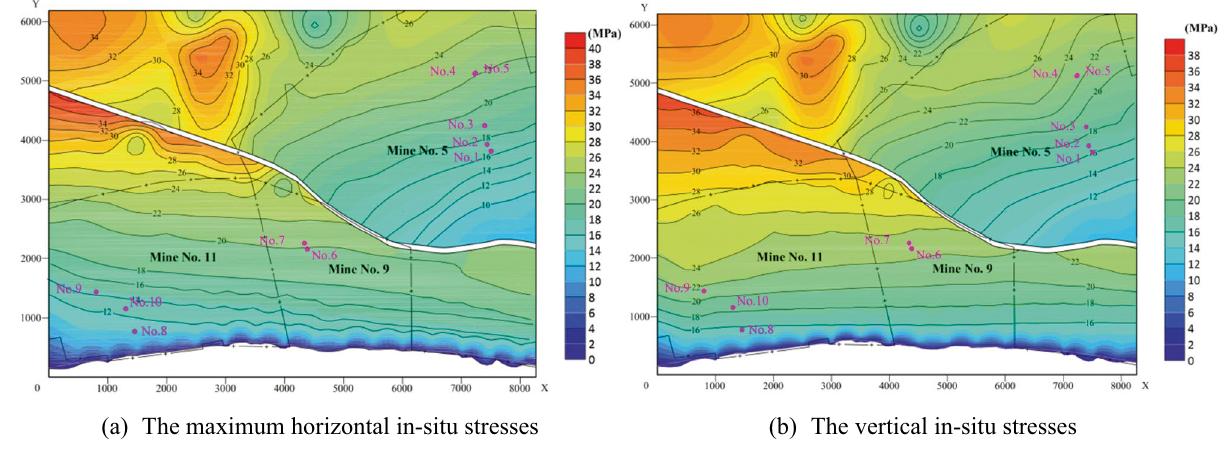
Figure 8. In-situ stresses distribution at the roof of Seam F 16-17 .